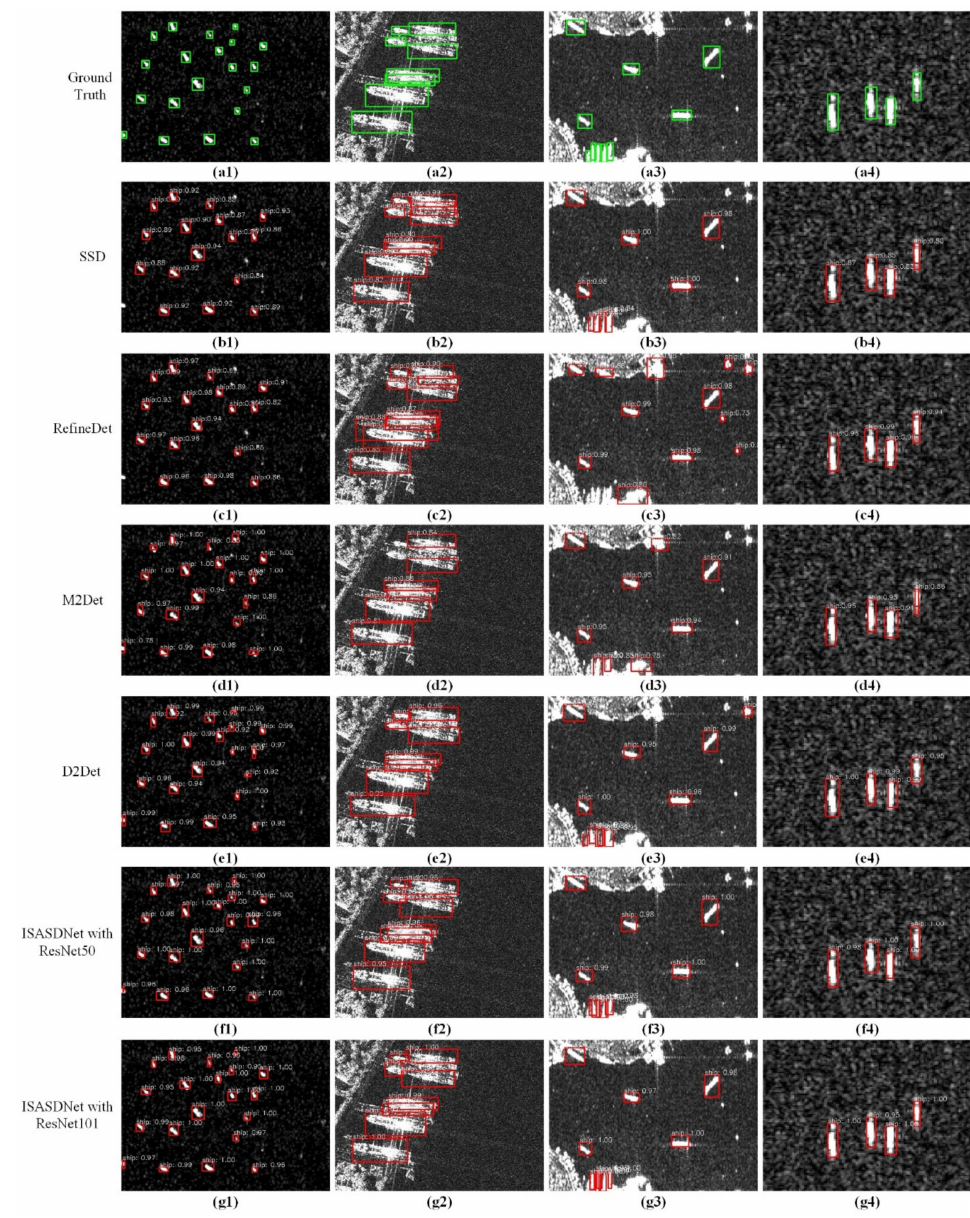
Figure 12. Experimental results on SSDD. ( a1 – a4 ) The first row contains ground truth images. ( b1 – b4 ) The second row contains the results of SSD. ( c1 – c4 ) The third row contains the results of RefineDet. ( d1 – d4 ) The fourth row contains the results of M2Det. ( e1 – e4 ) The fifth row contains the results of D2Det. The last two rows contain the experimental results of our algorithm: ( f1 – f4 ) the fifth row show the results obtained by ISASDNet with ResNet50, ( g1 – g4 ) and the sixth row shows the results obtained by ISASDNet with